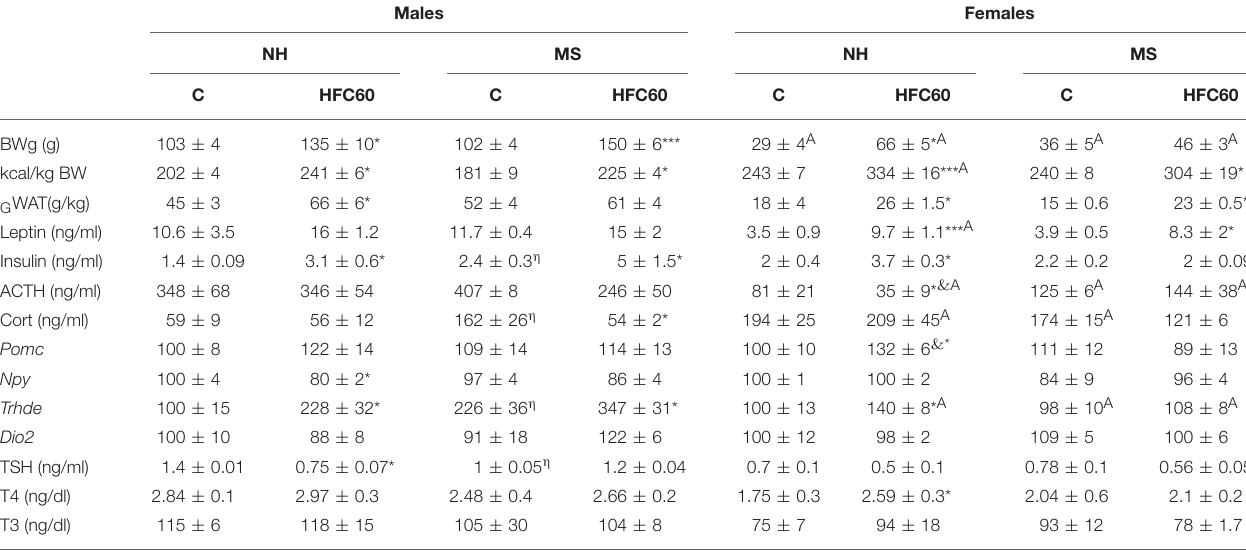
TABLE 1 | Effect of maternal separation and 1 month of a high-fat/high-carbohydrate diet on metabolic and HPT axis parameters (experiment 1). Males